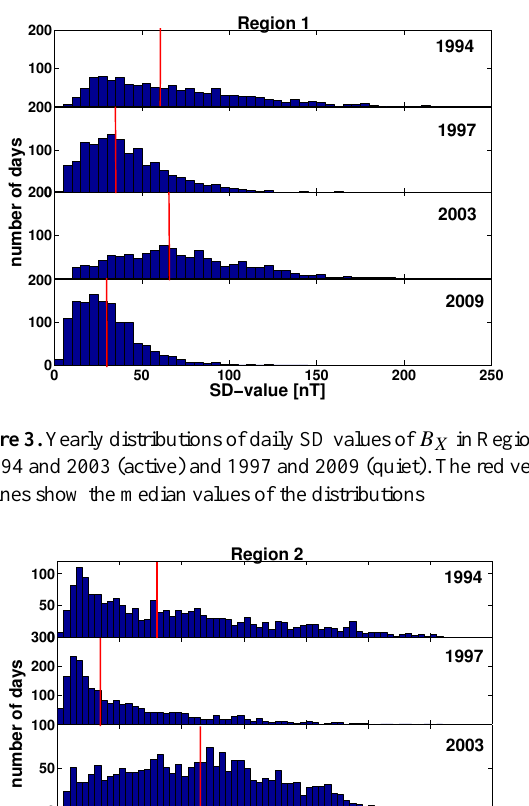
Figure 5. From top to bottom: number of sunspots, the percentage of the time when solar wind speed value exceeds 600kms − 1 , the number of CMEs (solid) together with the IMF magnitude (dashed line), SD values in Region 1, SD values in Region 2, SD values in Region 3 in 1994–2010, and the maximum geographic latitudes of the maximum eastward (blue) and westward (red) electrojet cur- rent densities in degrees. All the values are 13-month-smoothed monthly averages. The black dashed horizontal lines in the bot- tom panel show the southern boundary of Region 1 (upper line) and the northern boundary of Region 2 (bottom line). The blue dashed lines shows the starting and ending point of solar cycle 23 and the red dashed line show the month of the smoothed maximum sunspot